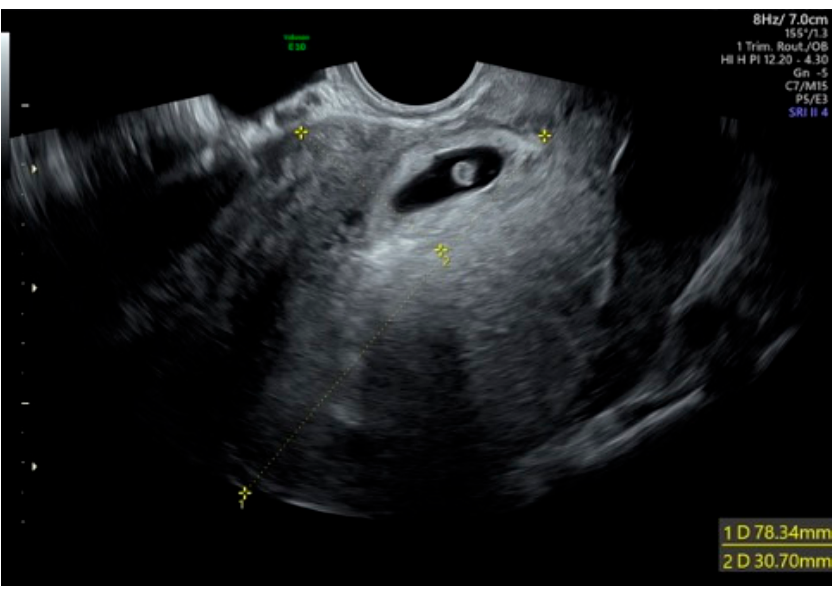
Figure 1. Cesarean scar pregnancy with cardiac activity.